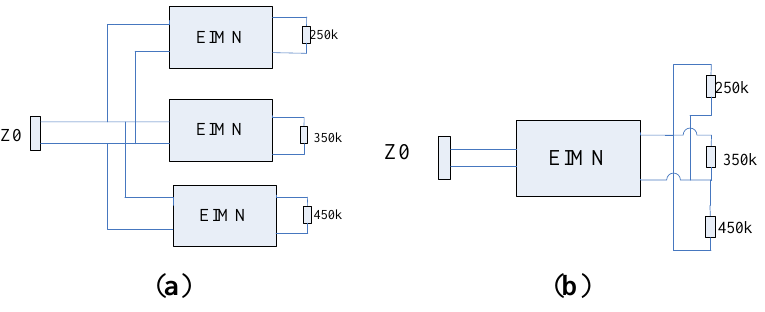
Figure 6. Different methods for matching the transducer array.